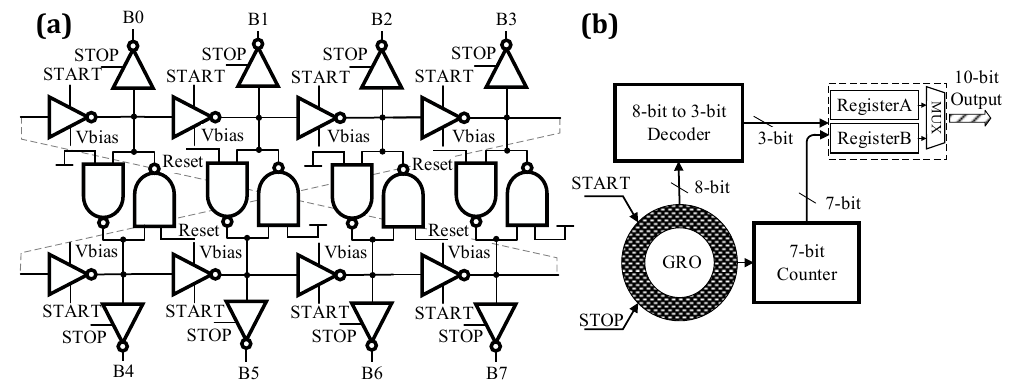
Figure 4. ( a ) The GRO circuit; ( b ) the structure of the 10-bit TDC.